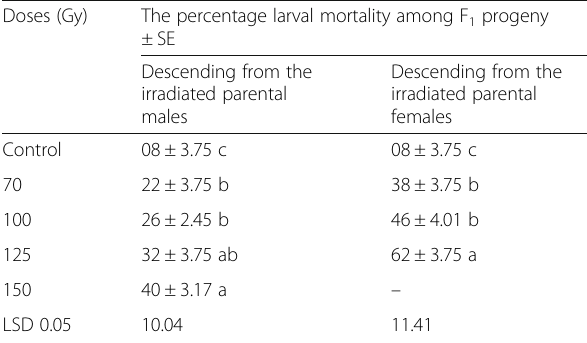
Means followed by the same letter in each column (small letters) represent those that are not significantly different at p >